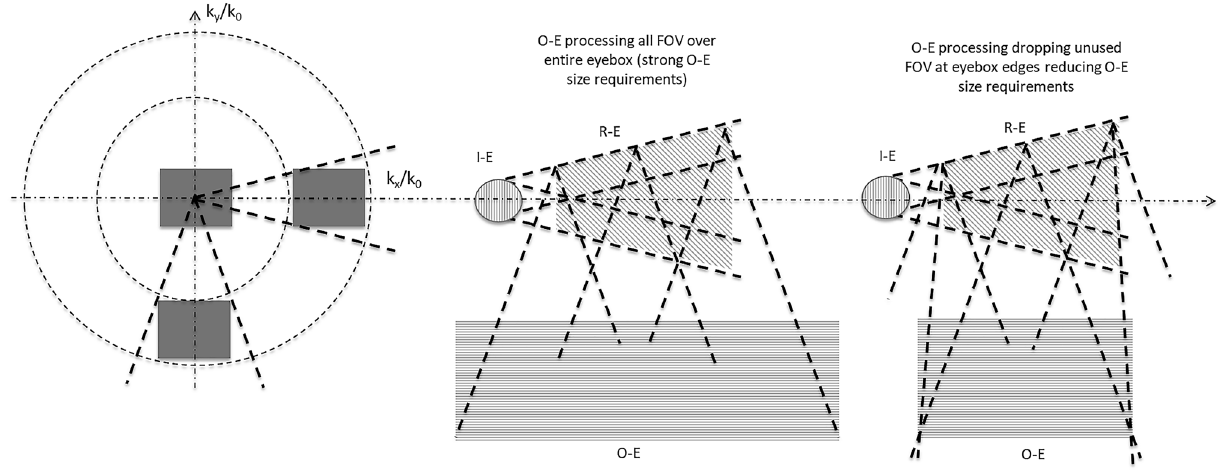
Figure 30: Redirection and out-coupler areas as dictated by the incoupled